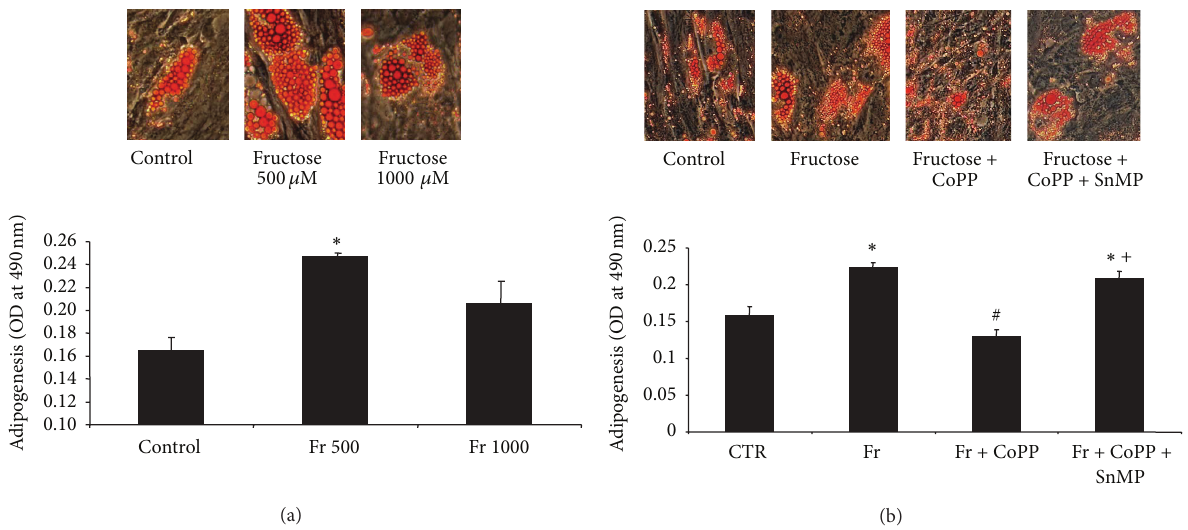
Figure 1: (a) Adipogenesis as shown by Oil Red O staining in MSCs treated with 500 𝜇 M and 1000 𝜇 M fructose. A representative section for each group is shown. (b) Adipogenesis as shown by Oil Red O staining in MSCs treated with 500 𝜇 M fructose with or without CoPP, in the presence or absence of SnMP, magnifications: 40x ( 𝑛 = 5 ). A representative section for each group is shown. Values represent means ± SEM of five independent treatments. ∗ 𝑝 < 0.05 versus CTR; # 𝑝 < 0.05 versus Fr; and + 𝑝 < 0.05 versus Fr +